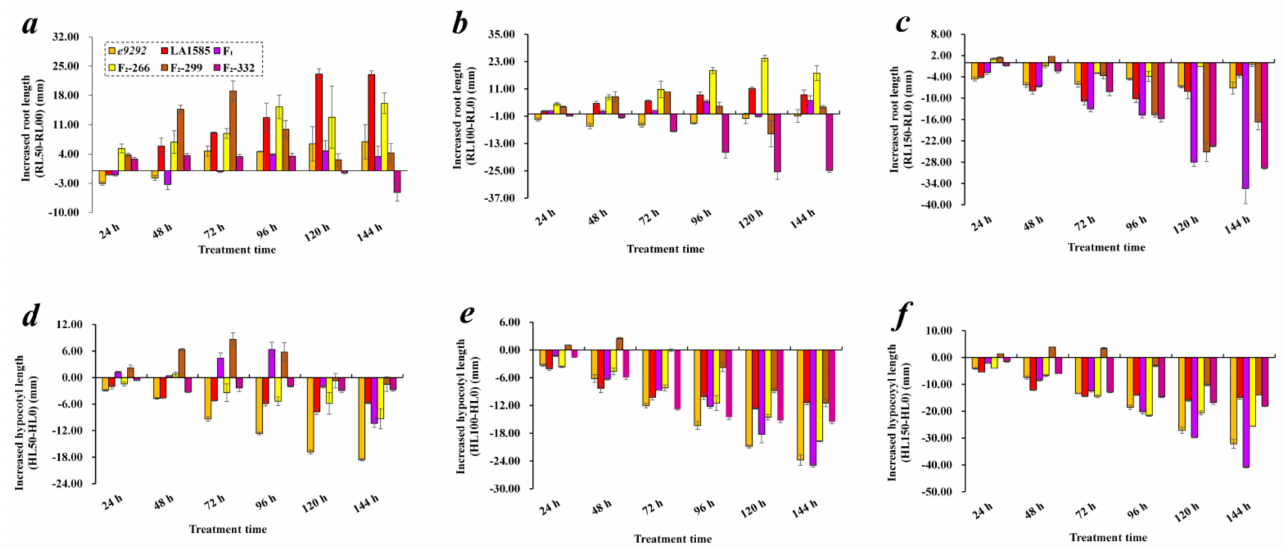
Figure 5. NaCl stress affects the root and hypocotyl growth of tomato seedlings. ( a – c ) Differences in the root length of seedlings with different genetic backgrounds between NaCl treatments (50 mmol/L to 150 mmol/L) and the control (0 mmol/L). ( d – f ) Differences in the hypocotyl length of seedlings with different genetic backgrounds between NaCl treatments (50 mmol/L to 150 mmol/L) and the control (0